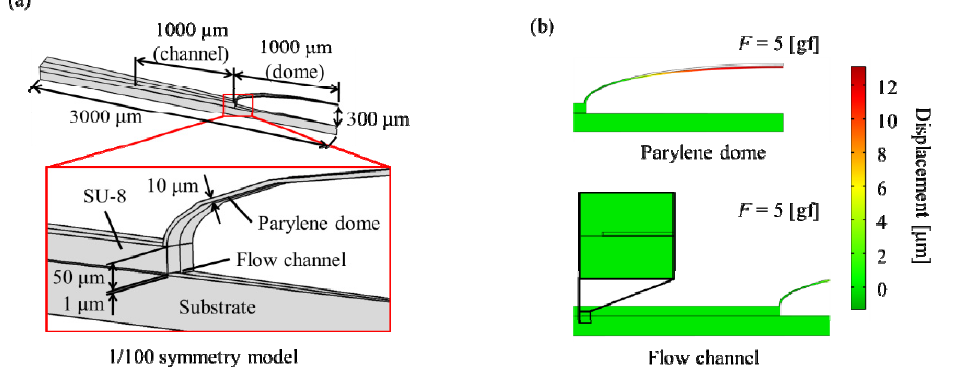
dome and flow channel.